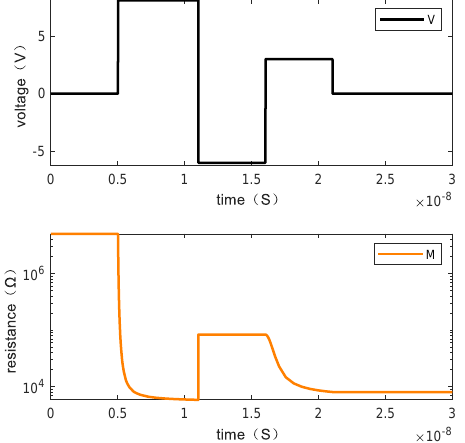
Figure 14. The changes of resistance value of the memory cell when writing “1101”.